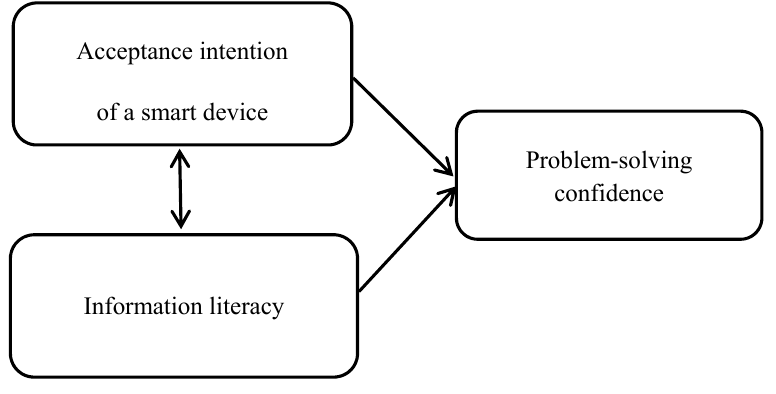
Figure 1. The hypothesized model.